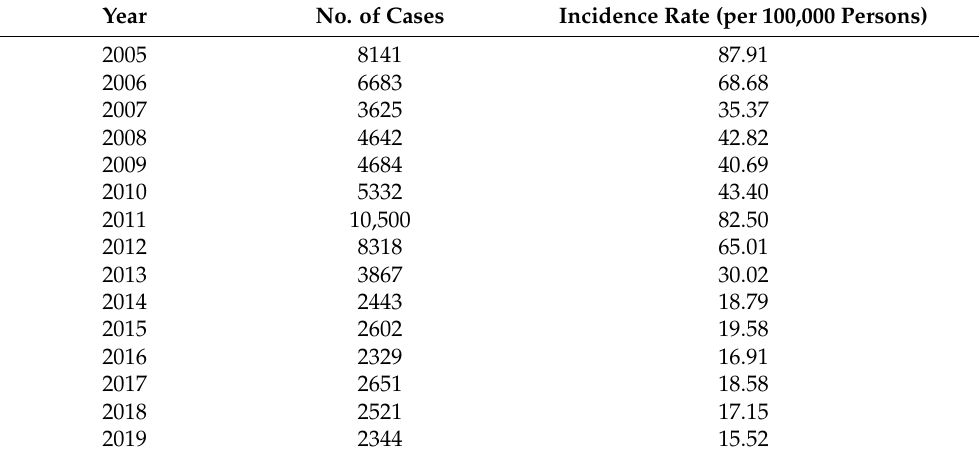
Table 1. Incidence rate and number of cases for yearly reported mumps in Guangzhou during